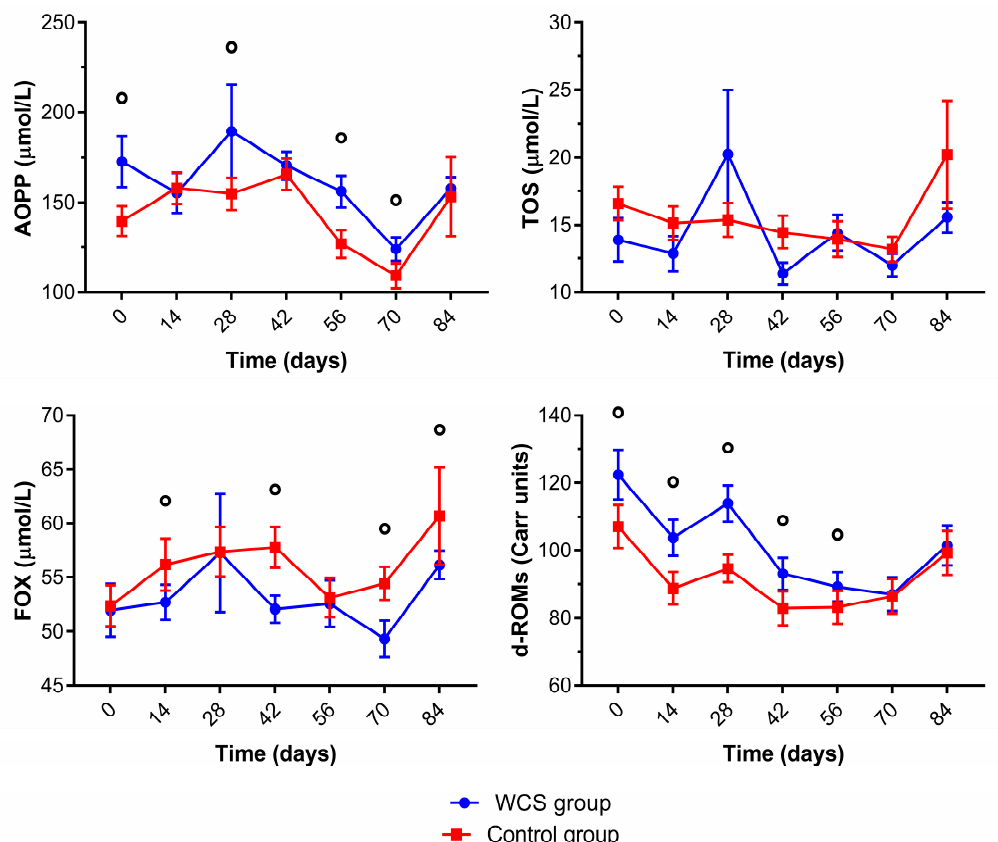
Figure 5. Mean (±standard error of the mean) of advanced oxidation protein products (AOPP), total oxidant status (TOS), ferric-xylenol orange (FOX), and reactive oxygen metabolites derived compounds (d-ROMs) concentrations of crossbred lambs naturally infected with gastrointestinal nematodes and Eimeria spp. receiving two different diets (whole cottonseed and control) at seven different samplings (0–84 days). There was an interval of 14 days between each sample collection. ° Significantly difference between groups.